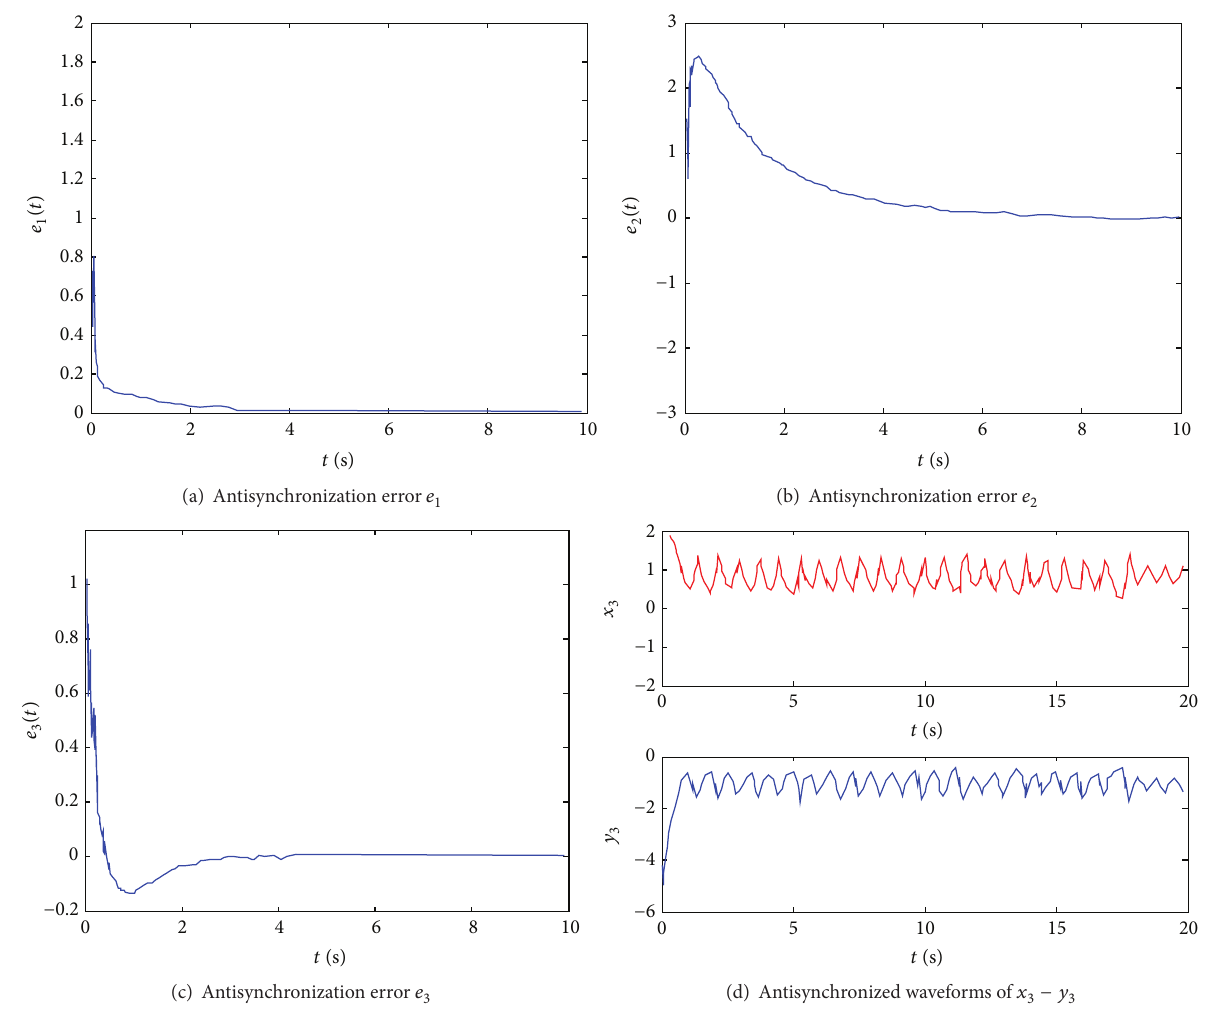
Figure 5: Antisynchronization error curves and waveforms based on the state